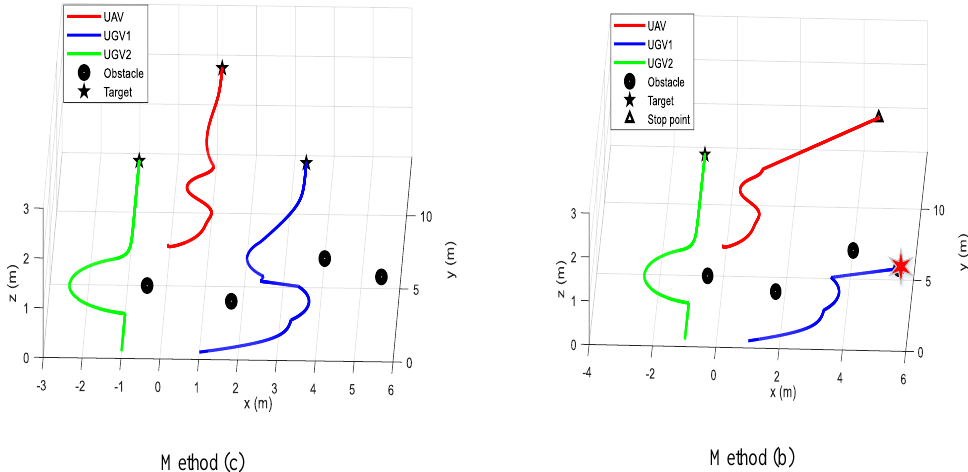
Figure 7. The picture shows the air-ground system trajectory of method (c) and method (b). In method (c), the UAV first sends out the wrong intervention task (UGV not received), and then sends out effective intervention task (UGV received). The UGV finally reaches the target point. In method (b), the UGV directly receives the wrong trajectory of the intervention task. The UGV encounters obstacles.